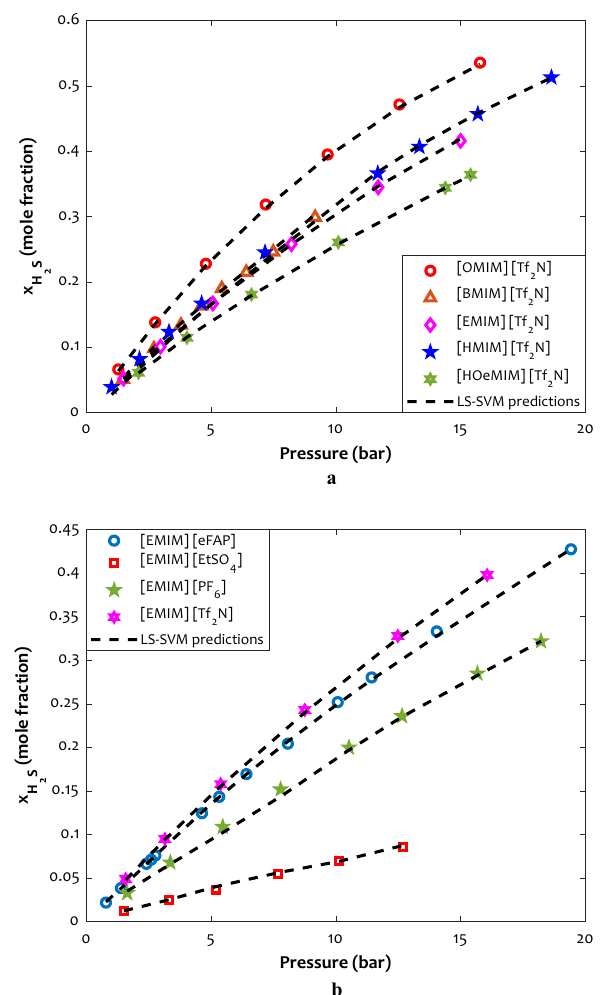
Figure 10. ( a ) The effect of cation type on the H 2 S solubility in [Tf 2 N]-contained ionic liquids (T = 343.15 K) ( b ) The influence of anion type on the hydrogen sulfide capture ability of the [EMIM]-contained ionic liquids (T = 353.15